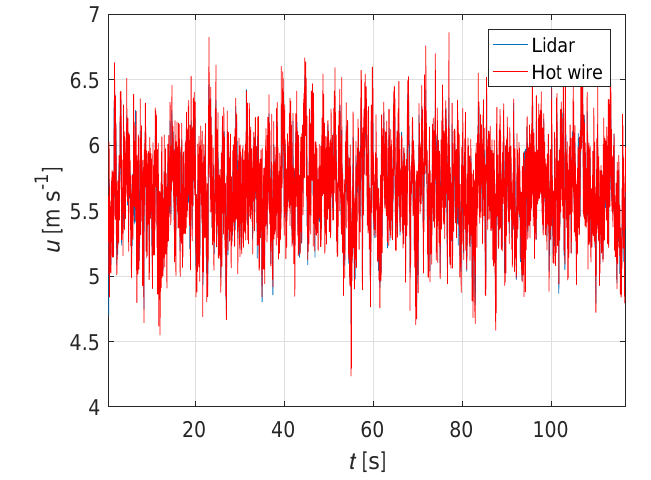
Figure 10. Visual comparison of the 390Hz u component. Figure 11. Visual comparison of the 390Hz v component.